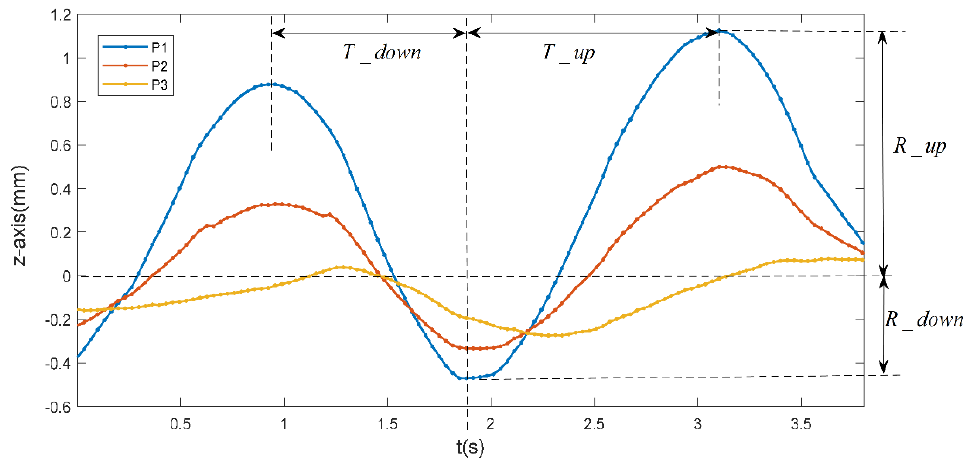
Figure 2. Pectoral fin feature point motion trajectory.